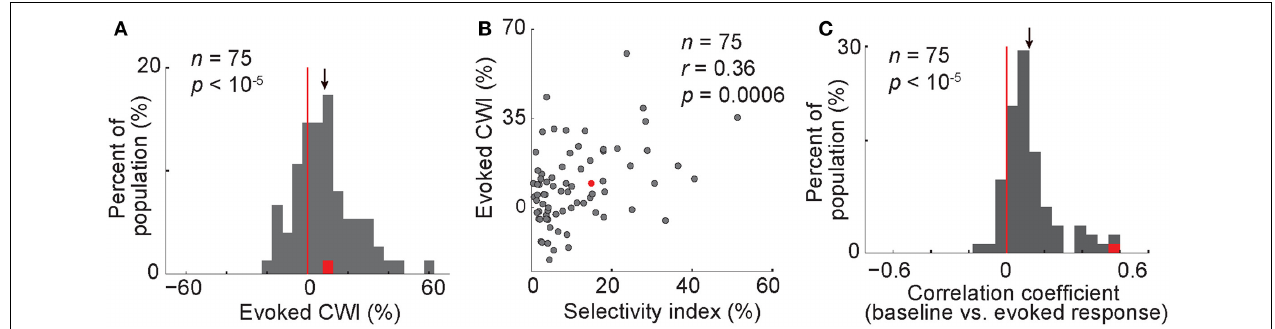
FIGURE 5 | Modulation of the evoked response in correct vs. wrong trials; correlation of baseline and evoked responses. (A) Histogram of the CWI of the evoked response. (B) The relationship of the evoked CWI with the